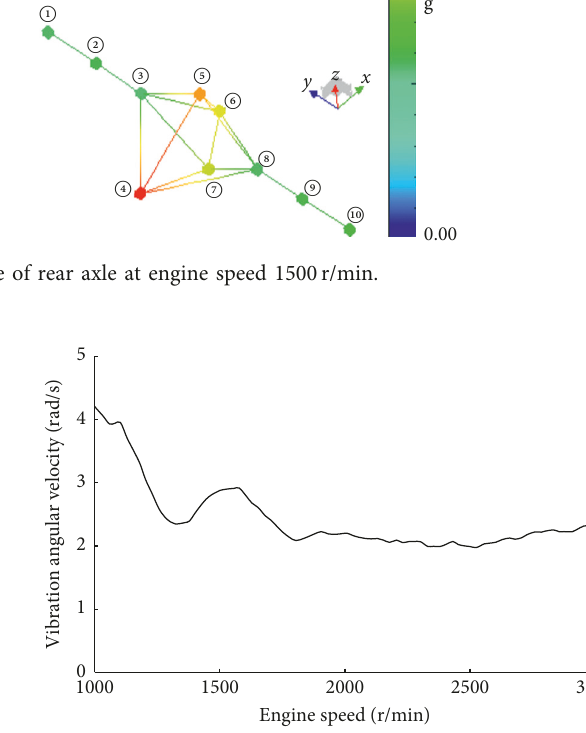
Figure 14: Angular velocity fluctuation of propeller shaft input